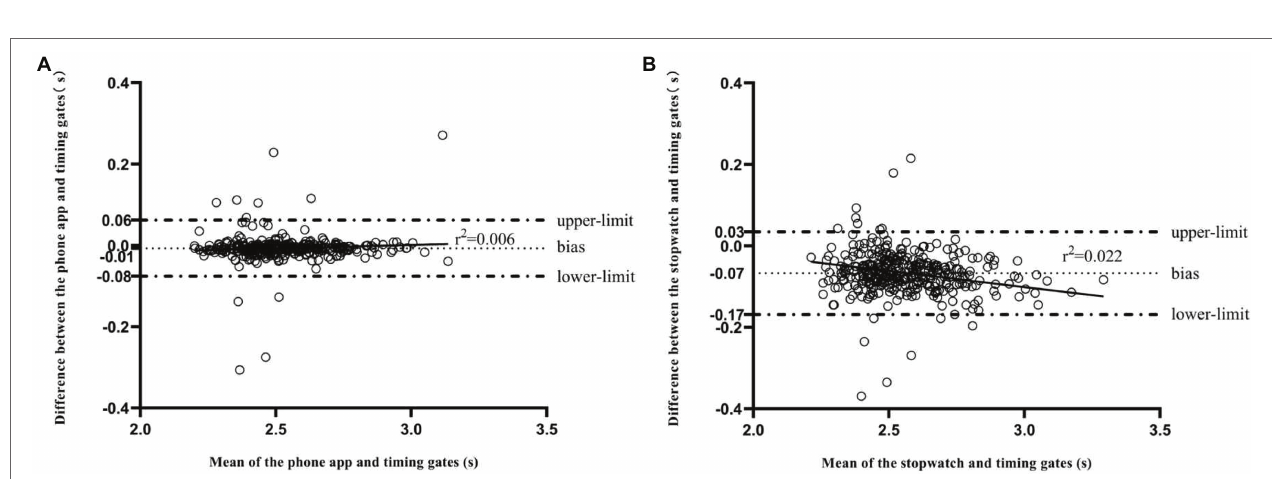
FIGURE 3 | Bland-Altman plots for the measurement of completion time between devices: (A) phone app and timing gates; (B) stopwatch and timing gates. The central thin dashed line represents the absolute average difference between devices, and upper and lower horizontal lines represent the observed bias with 1.96 standard deviations ( SD ), while the solid line is the regression line of the